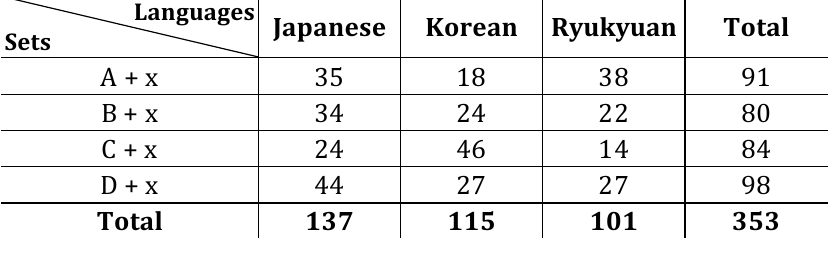
Table 11: Distribution of disyllabic nouns in the three historical sources (focusing on the first